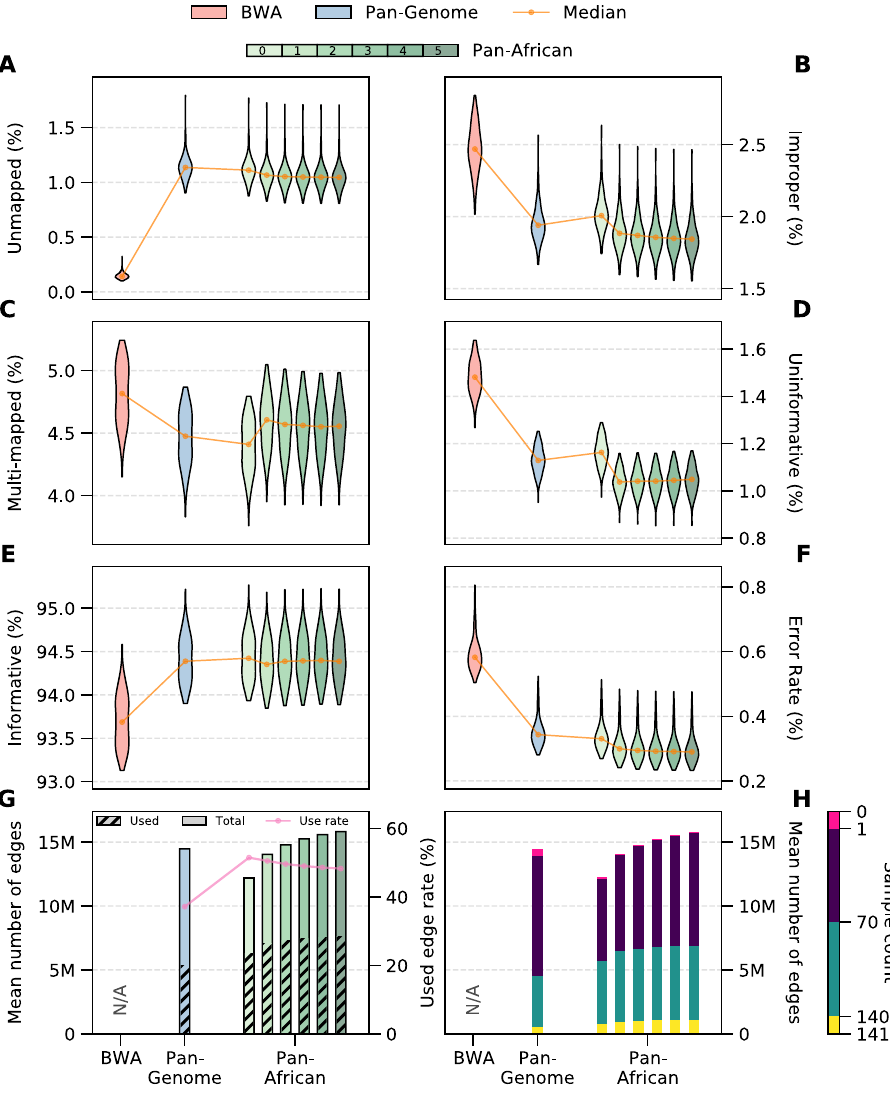
Fig. 3 Alignment metrics for BWA (red), Pan-Genome (blue), and Pan-African Iterations (green). Rate of unmapped ( A ), improper ( B ), multi-mapped (MAPQ = 0) ( C ), uninformative (MAPQ < 20) ( D ), and informative reads (MAPQ ≥ 20) ( E ). F Alignment error rate. Error rate is the ratio of mismatches to aligned bases in read alignments with respect to the reference. Two-sided Wilcoxon tests between consecutive distributions are performed. In all cases, except for one (uninformative reads between iterations 2 and 3), the difference is signi fi cant ( p < 10 − 3 ). G Total number of variants in graph (solid bars) and per sample mean of number of used variants/edges in alignment (dashed bars). Magenta line shows the ratio of used variants to the graph size. H Categorization of variant utilization in alignment with respect to the number of samples: 0% (pink), below 50% (purple), above 50% (green), 100% (yellow). Source data are provided as a Source Data fi